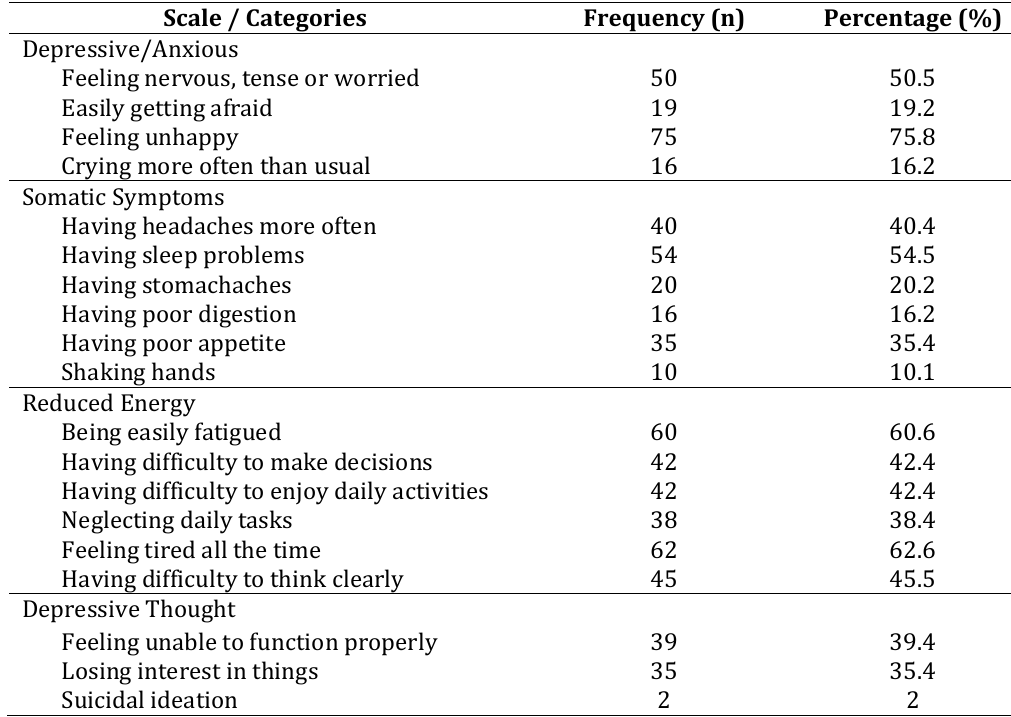
Prevalence of common mental disorder symptoms in